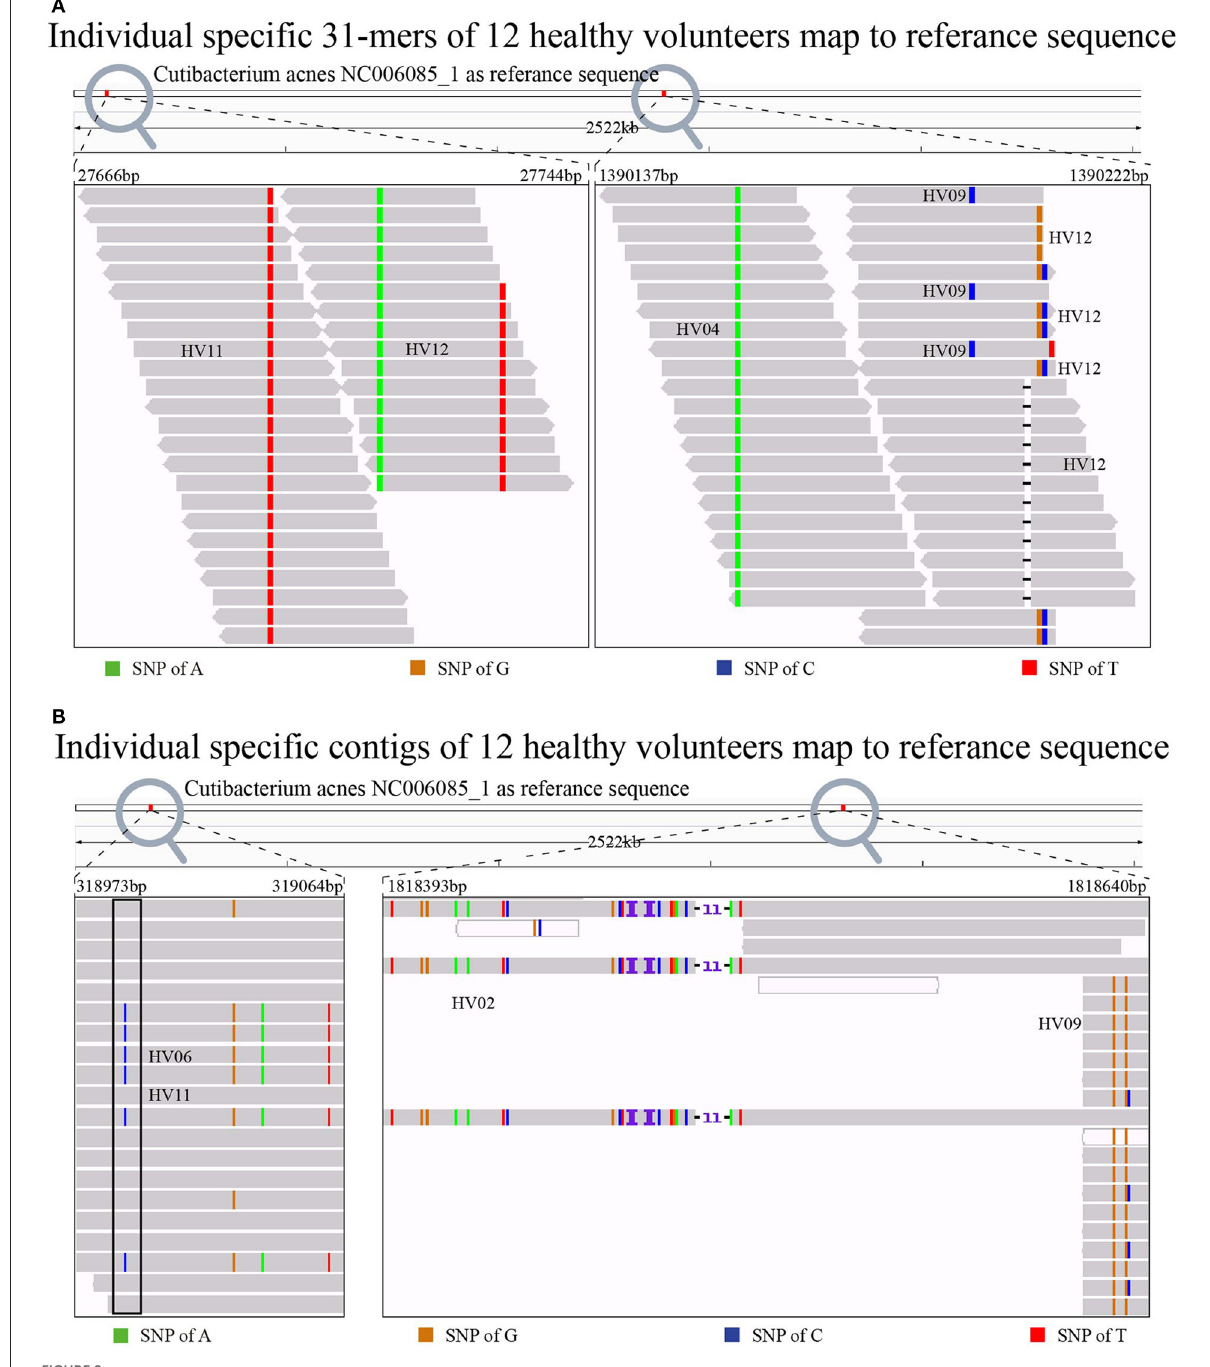
FIGURE8 Individual-specific 31-mers (A) and contigs (B) alignments in Cutibacterium acnes , respectively. Each individual has his/her unique genetic variants, even though multiple individuals match the same region. For example, in the left of (A), HV11 and HV12 both match the middle 318,681bp-319,906bp region, but HV11 has an individual-specific genetic variant of T, and HV12 has an individual-specific genetic variant of A. The same is found in the left of (B) where individual-specific contigs of HV06 and HV11 both align at position 318,983bp-319,104bp, but only HV06 has specific genetic variants at fixed position 318,989 with a base mutation of